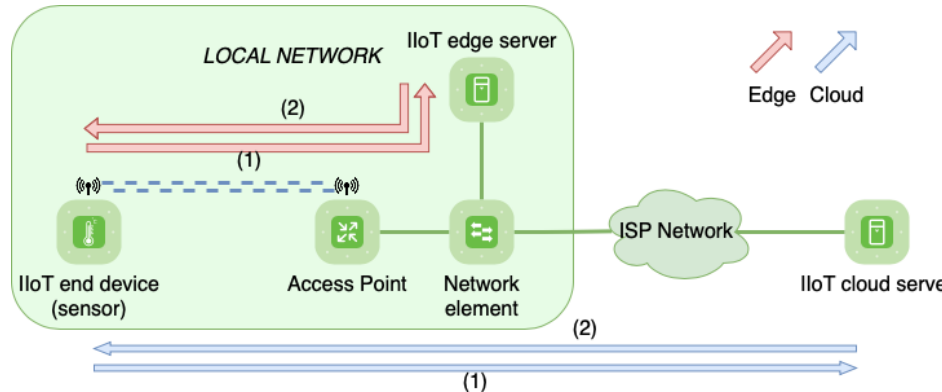
Figure 2. Edge and cloud communication in an industrial